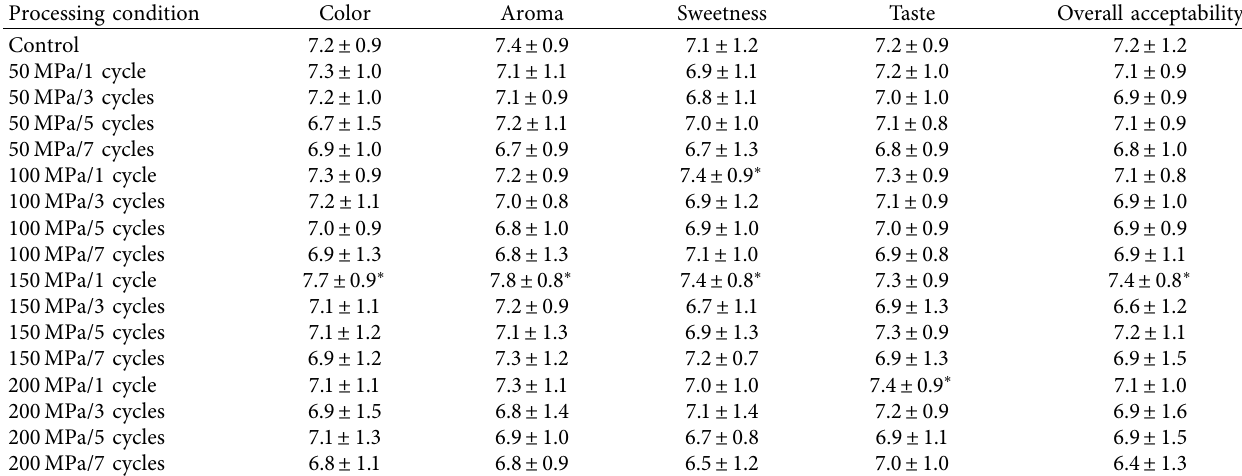
Table 2: Sensory characteristics of control and microfluidized sugarcane